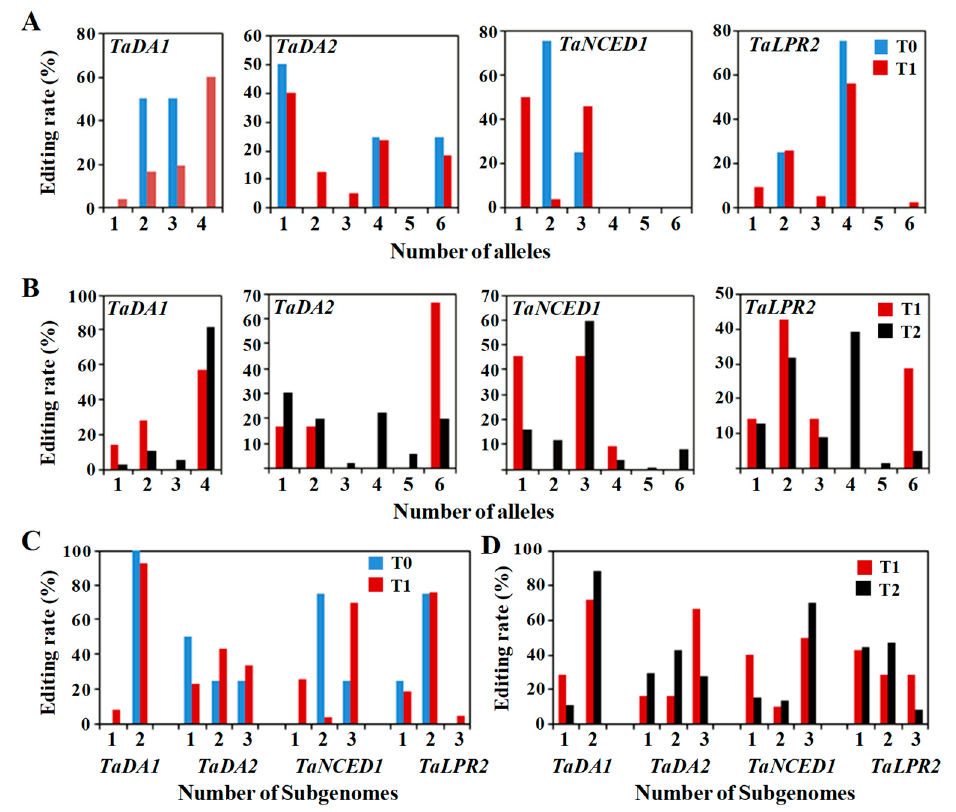
Figure 6. The editing rates of alleles and subgenome numbers of the target genes in each generation. ( A ) Editing frequency of the alleles in T0 and T1 generations. ( B ) Editing frequency of alleles in the four selected T1 plants and their T2 progeny. ( C ) Editing frequency of the subgenomes in the T0 and T1 generations. ( D ) Editing frequency of subgenomes in the T0 and T1 generations in the four selected T1 plants and their T2 progeny.